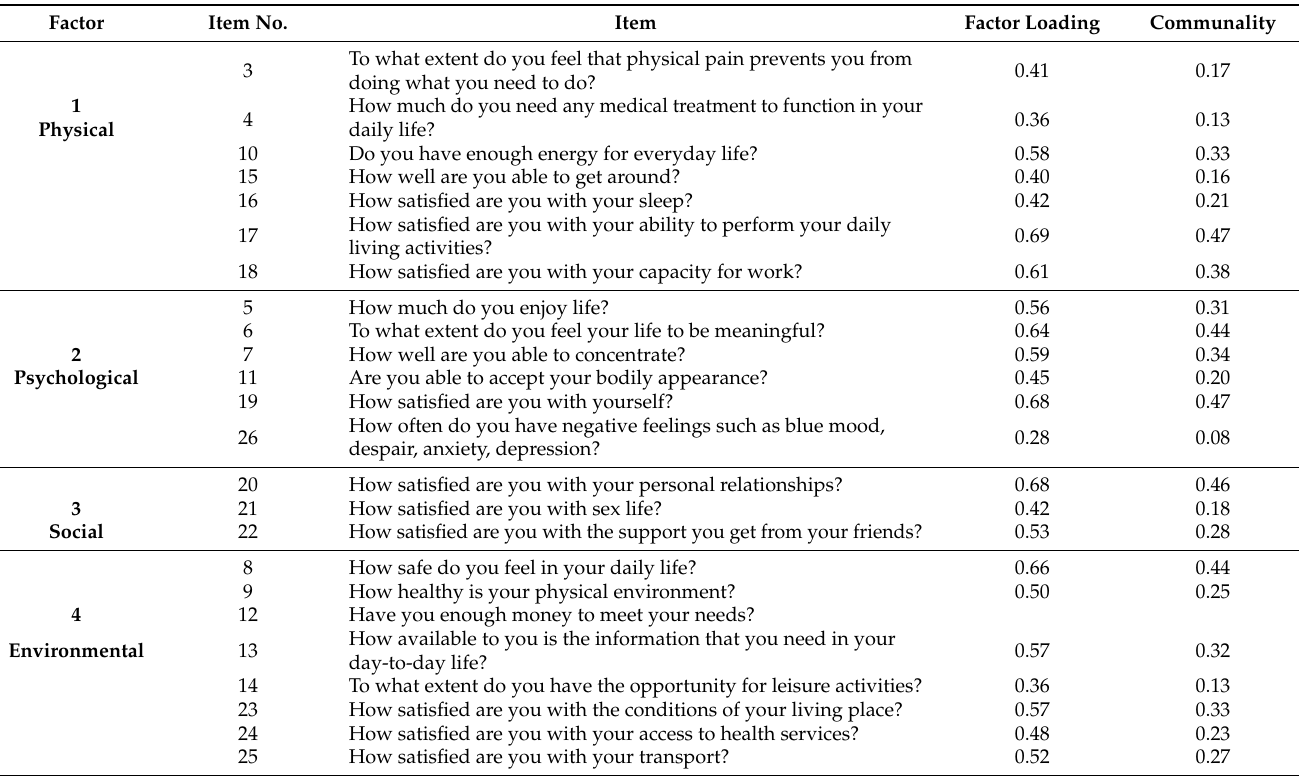
Table 2. Factor loading and communalities.